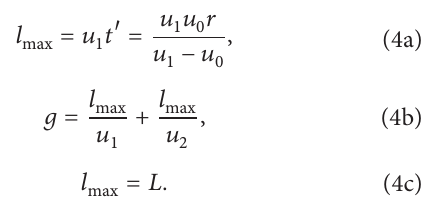
Figure 3: (a) Concave fundamental diagram; (b) triangular funda- mental diagram.